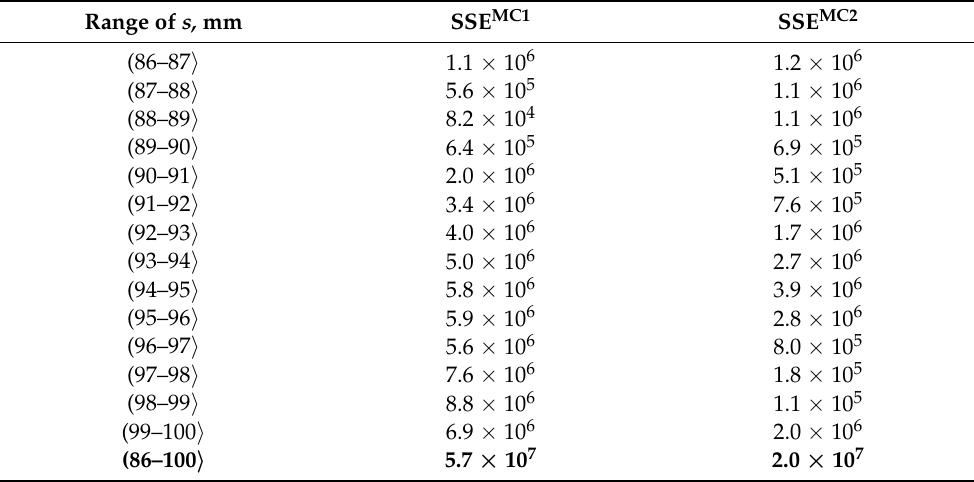
Table 3. Values of SSE for constant and varying parameters of the model. Range of s,